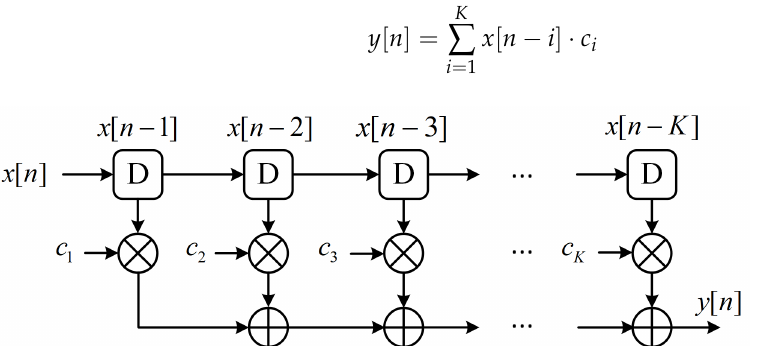
Figure 1. Conventional hardware architecture of FIR filter